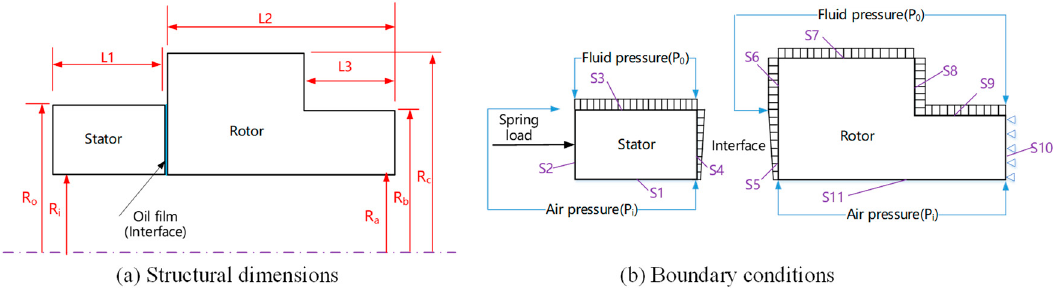
Figure 2. Mechanical seal simulation model.